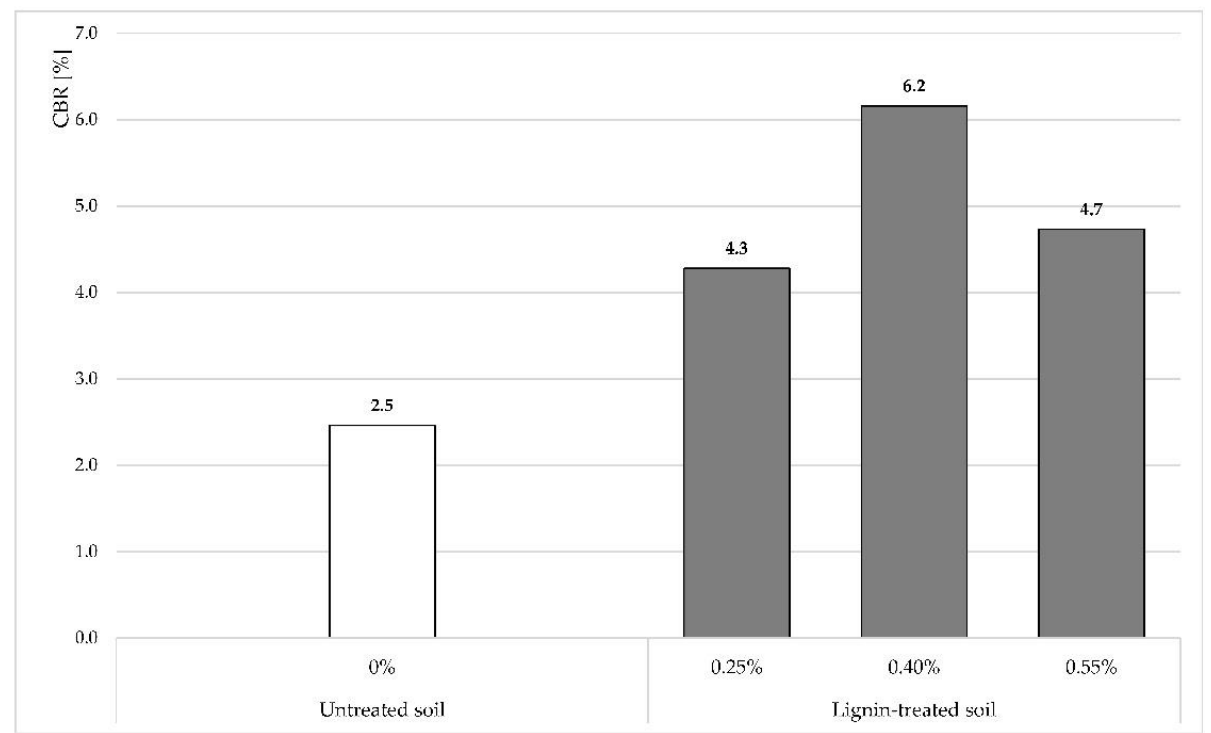
Figure 6. CBR values recorded for the untreated soil and the lignin-treated soil, respectively. In addition, CBR was tested after air-drying the material for 7 days to investigate the effects of the curing time on mechanical performance. CBR data were collected for specimens tested after dry and wet conditioning. Table 3 reports CBR values for dry and wet tests, respectively. The wet test refers to values obtained for specimens submerged in water for 4 days at the end of the seventh air drying day and before testing. Table 3. Effect of curing time on CBR values for the untreated soil and the lignin-treated soil, respectively.